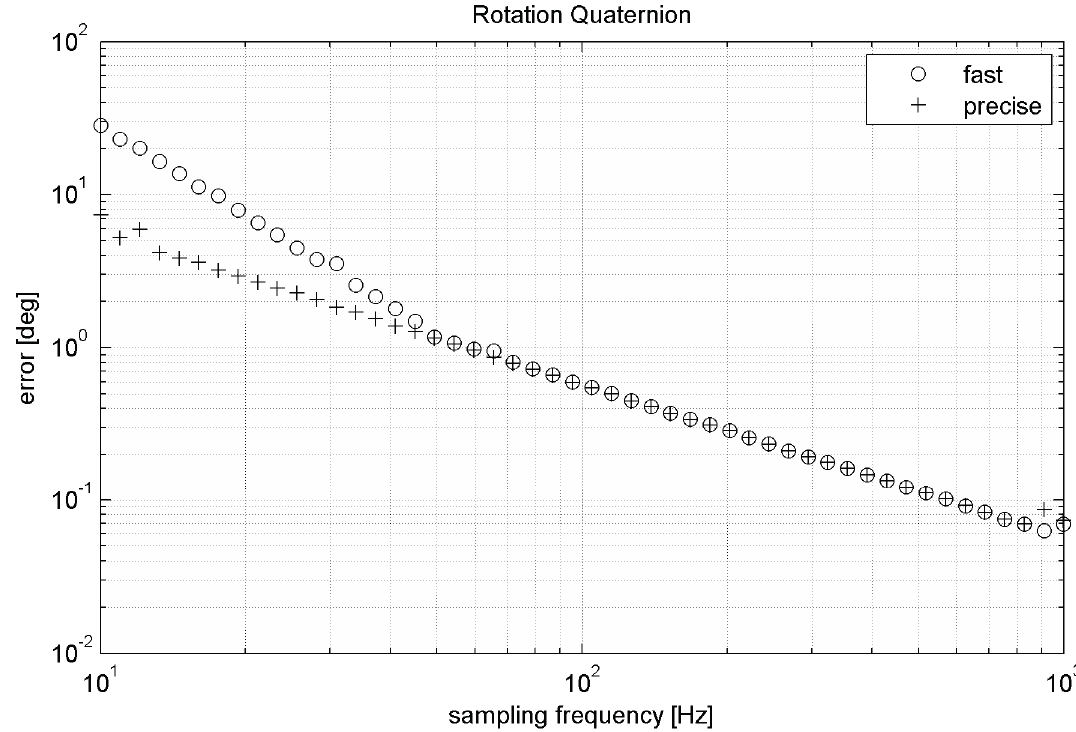
Figure 12. Errors of the quaternion-based algorithms during simulated